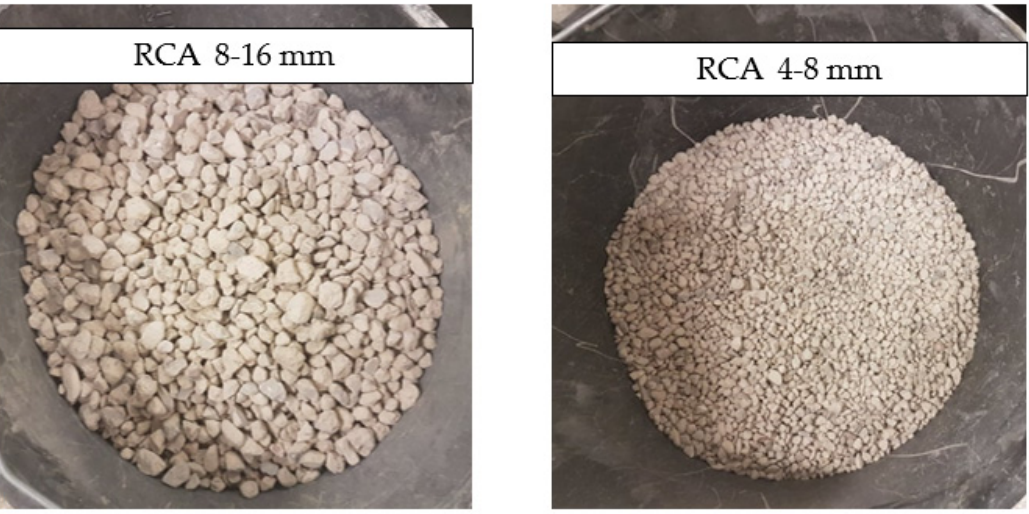
Figure 1. Recycled concrete aggregate (RCA): 8 – 16 mm fraction (on the left ) and 4 – 16 mm fraction (on the right ).